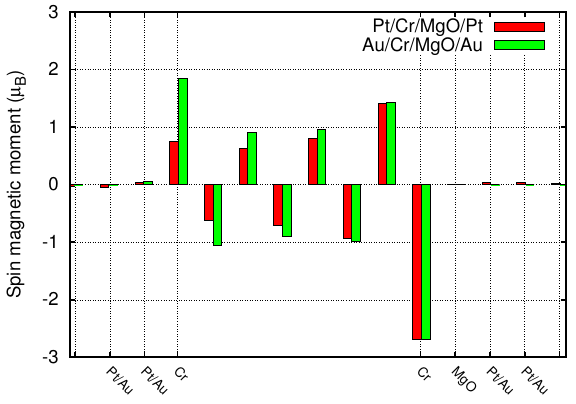
Figure 5. Spin magnetic moments along the junction constituted by Pt or Au leads plus 8 layers of Cr and a MgO monolayer.